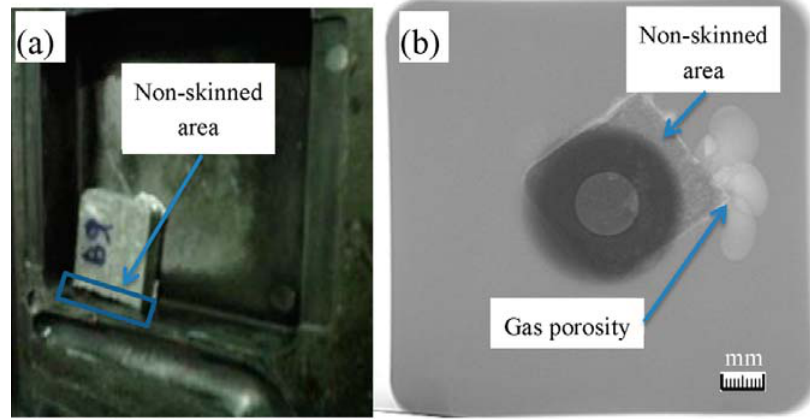
Figure 13. ( a ) Placement of a skinned foam with a non ‐ skin area in the die; and ( b ) release of gas from the foam in the non ‐ skinned area.